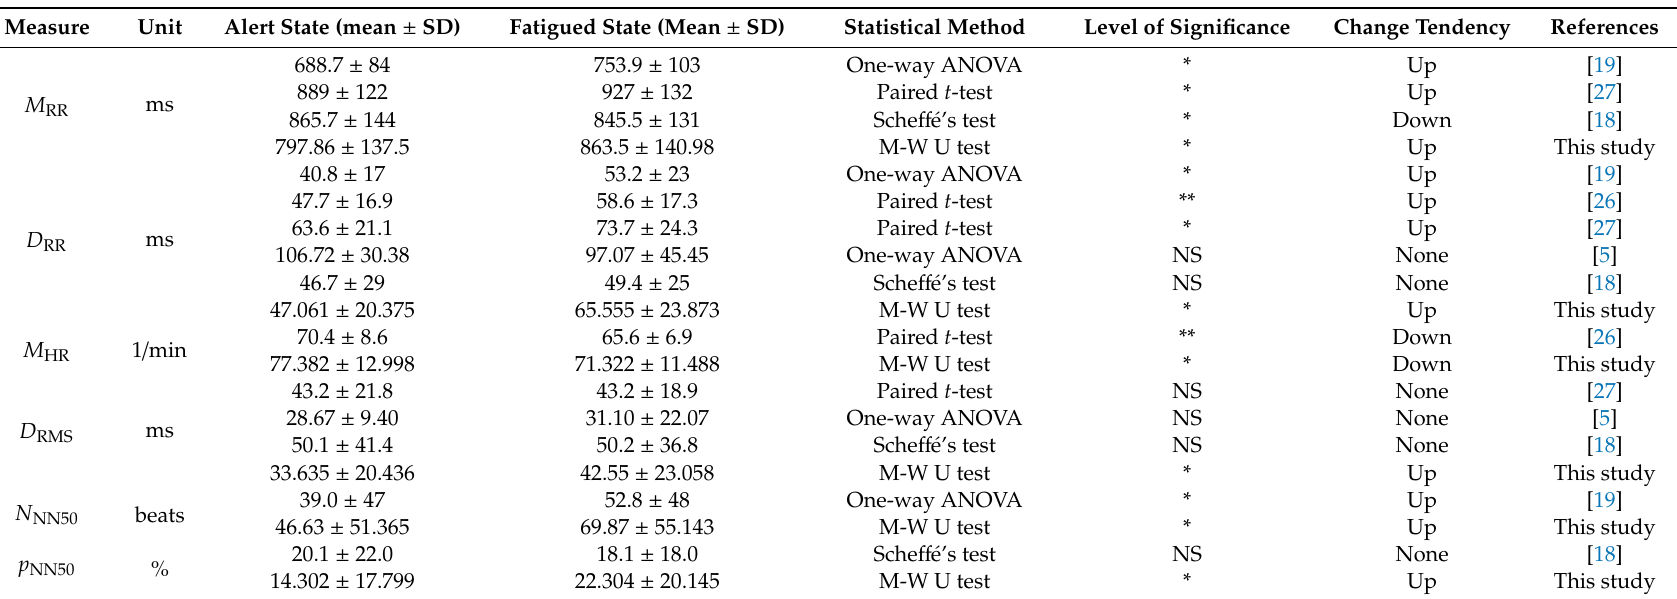
Table 7. Research results related to HRV time domain measures of drivers in di ff erent mental